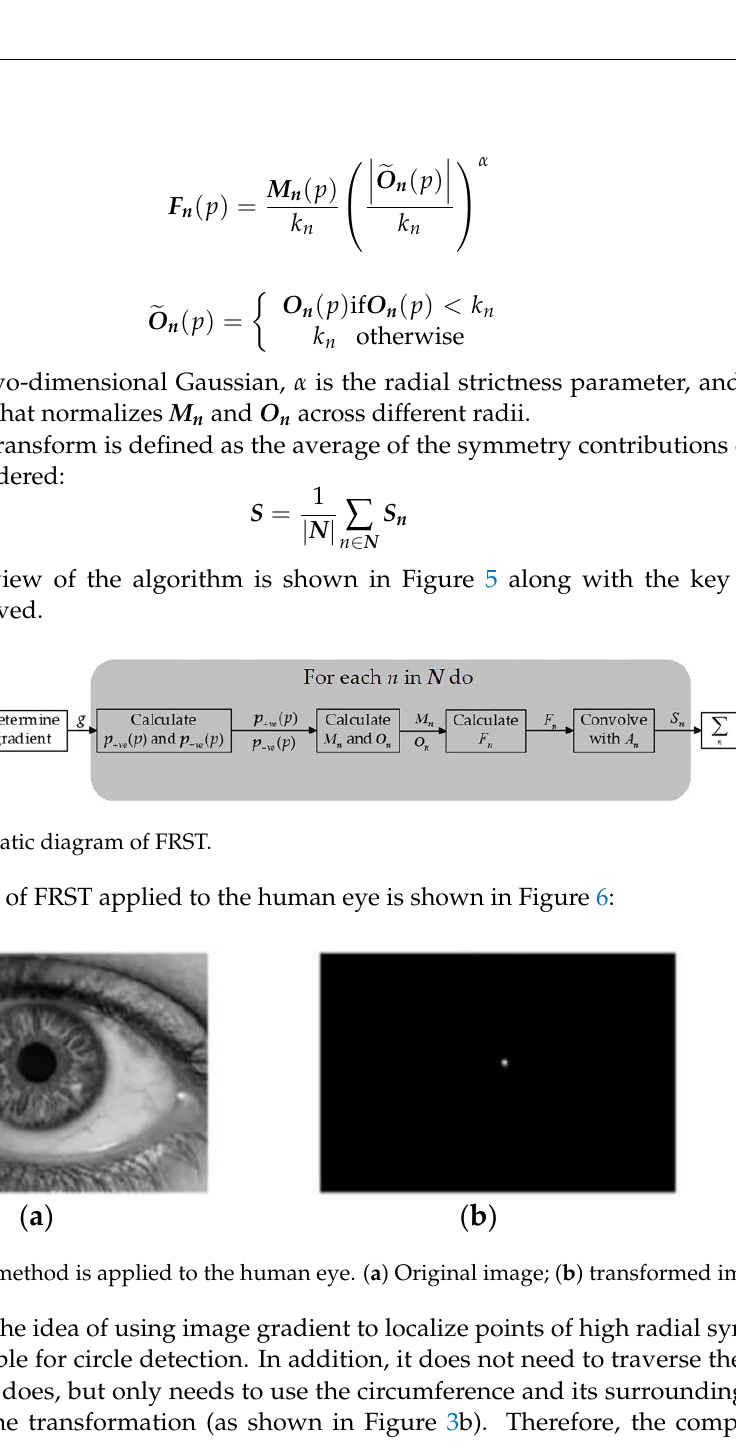
( d ) Figure 7. Comparison of results. ( a ) Original image; ( b ) when the radius is 23.5; ( c ) when the radius range is [20,27]; ( d ) when the radius range is [1,34]. It can be seen that: 1. When the floating roof of the oil tank is lower than the tank wall, there will be two areas that are brighter and darker in the image (as shown in Figure 7a), which makes positively affected pixels and negatively affected pixels at the boundary of the floating roof offset each other during transformation. Thus, the distribution of pixel values of ori- entation projection image and magnitude projection image is affected, and the final trans- formation result is affected. The solution to this problem in this study is to change the processing object of FRST from pixel to gradient modulus of pixel and cancel the posi- tively affected pixel. Since the positively and negatively affected pixels play decisive roles in aggregating “ black circle ” (circle whose contour is darker than the background) and “ white circle ” (circle whose contour is brighter than the background), respectively, the coexistence of these two pixels makes FRST have the function of aggregating both “ black circle ” and “ white circle ” on an image. However, when the circle in the image is not a Commented [M3]: Incorrect ref order, 34 detected after 27. You jumped the numbers in between. Please revise. Commented [jh4R3]: “ [20,27] ” and “ [1,34] ” represent two value intervals.